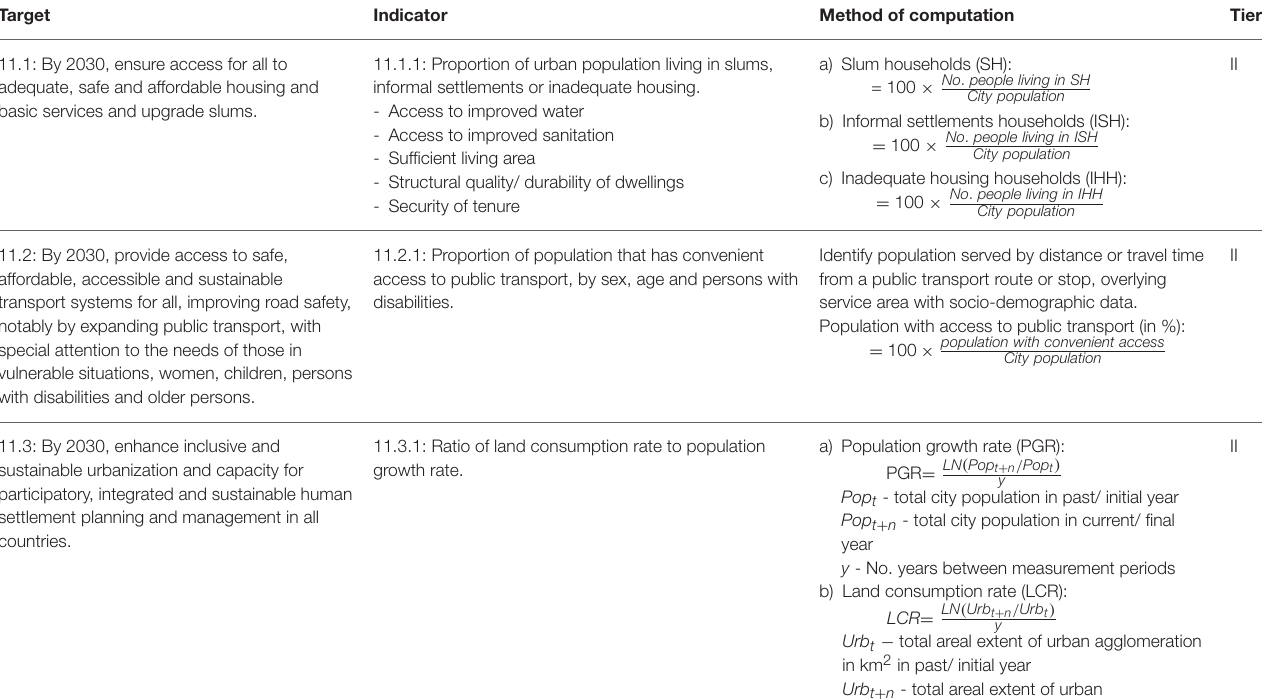
TABLE 1 | Sustainable Development Goal 11+ (SDG11+) indicators and targets (UN-Habitat et al., 2016). Target Indicator Method of computation